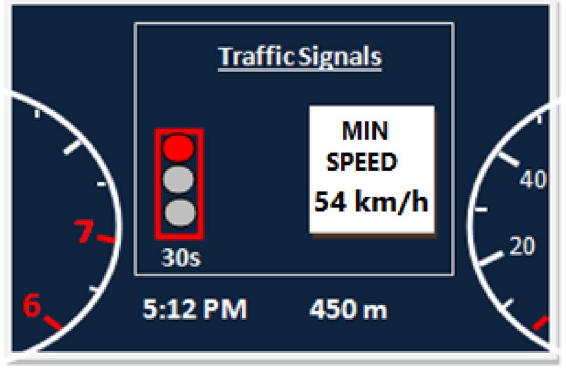
Figure 3. The traffic light signal information appears on the dashboard of the